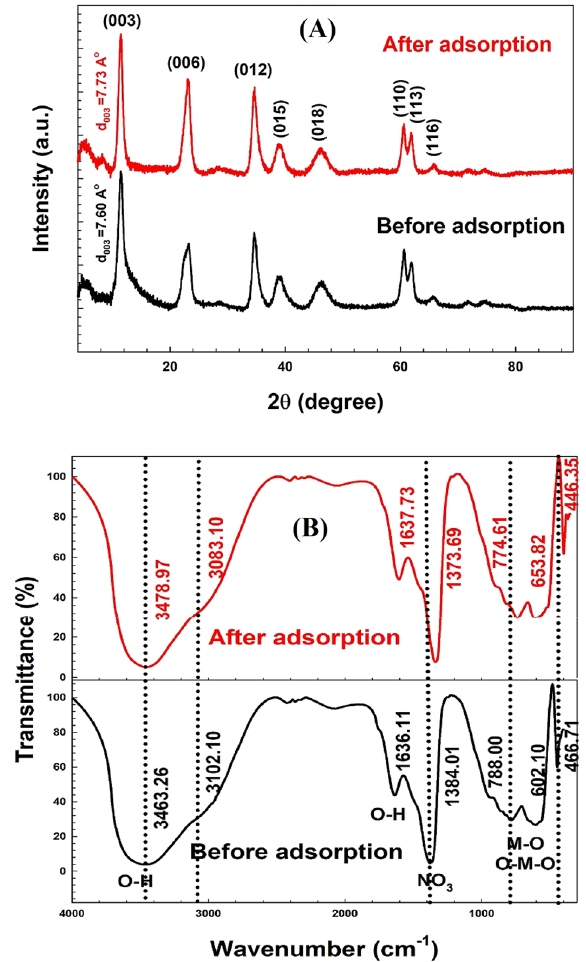
Figure 2. ( A ) XRD patterns and ( B ) FTIR spectra of Zn–Mg–Al/LDH before and after the adsorption of